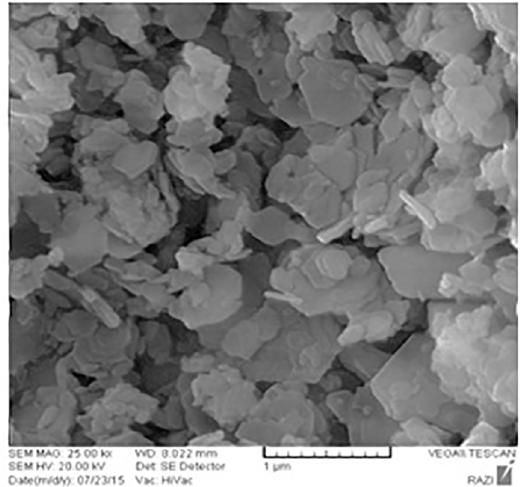
Figure 2. SEM image of synthesized calcium hydroxide In order to study the formation of hydroxyapatite and its evolution during heating time, the samples were calcined at 700 ºC without Ti powder. Fig. 3 shows the XRD pattern of the calcined Ca(OH) and DAP 2